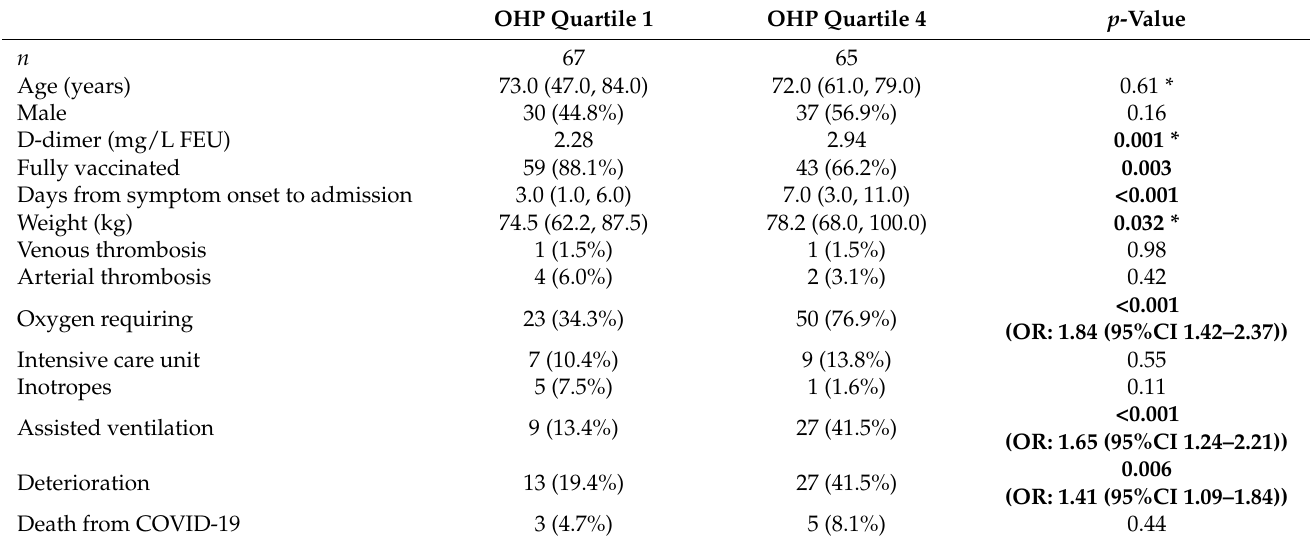
Table 4. Clinical outcome of COVID-19 patients from 2022, comparing those with the highest OHP quartile to the lowest OHP quartile. Data are n (%), and median (interquartile range, IQR), unless specified otherwise.